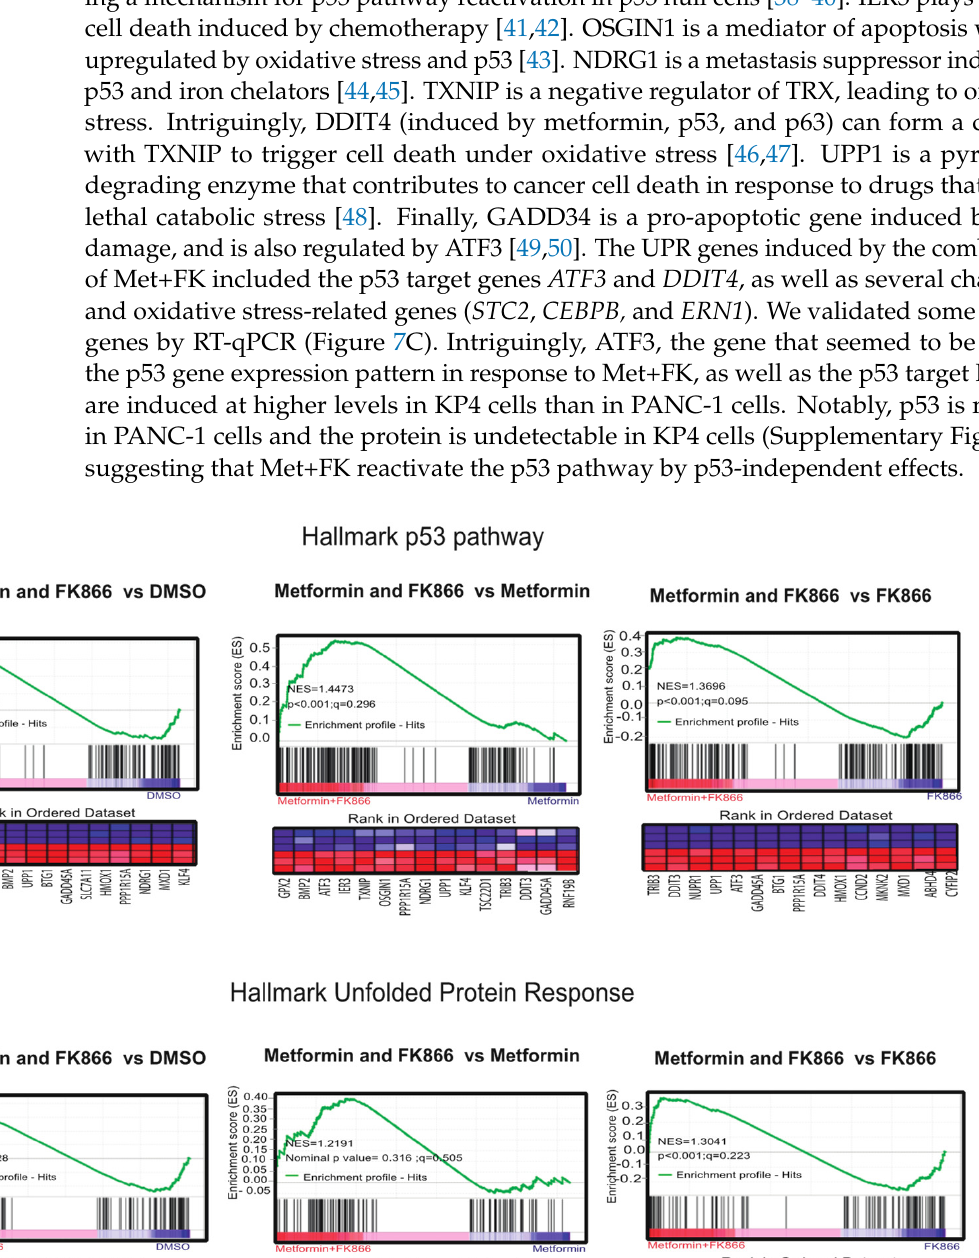
Figure 7. The combination of Met+FK activates the p53 pathway and the unfolded protein response (UPR). ( A ) p53 gene set that overlaps with gene expression changes in KP4 cells treated with met- formin and FK866 in comparison to vehicle, metformin alone, or FK866 alone. ( B ) UPR gene set that overlaps with gene expression changes in KP4 cells treated with metformin and FK866 in compari- son to vehicle, metformin alone, or FK866 alone. ( C ) RT-qPCR validation of some gene expression differences found in ( A ) and ( B ). Data are normalized over TBP and HMBS and presented as means relative to control cells (vehicle condition). Values are means of triplicates ± SEM. * p -value ≤ 0.05, ** p -value ≤ 0.01, *** p -value ≤ 0.001, **** p -value ≤ 0.0001 (ANOVA), n = 3.